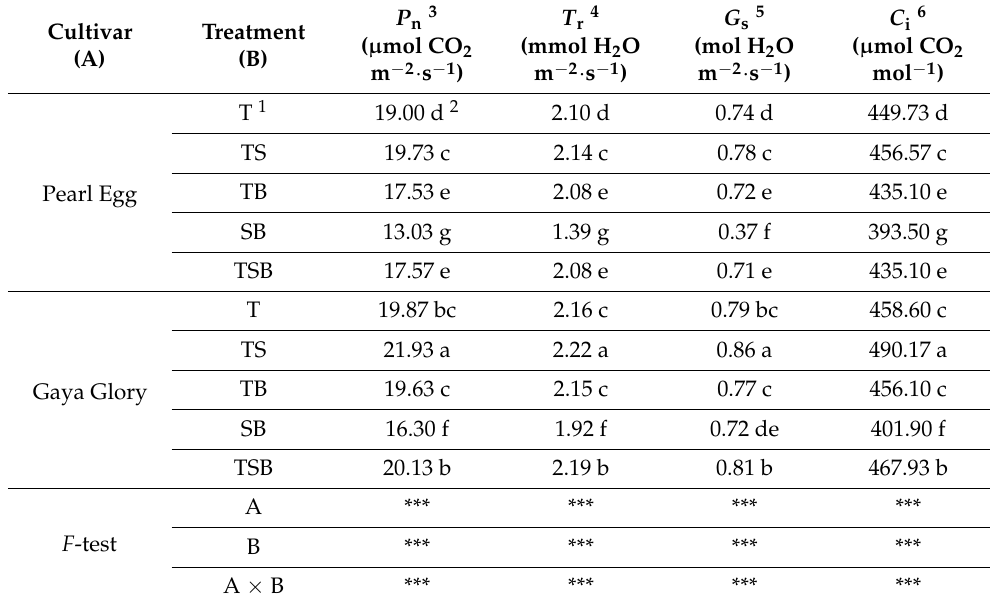
Table 2. Influence of the lighting direction combinations on the photosynthetic characteristics of chrysanthemums grown for 45 days.